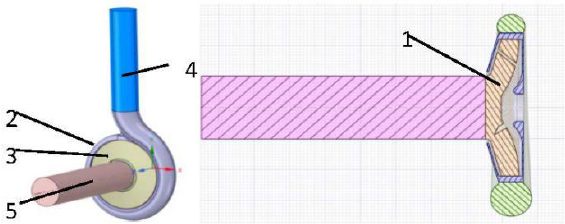
Figure 6. Flow region, with ( 1 ) impeller; ( 2 ) volute; ( 3 ) case; ( 4 ) inlet pipe; and ( 5 ) outlet pipe.